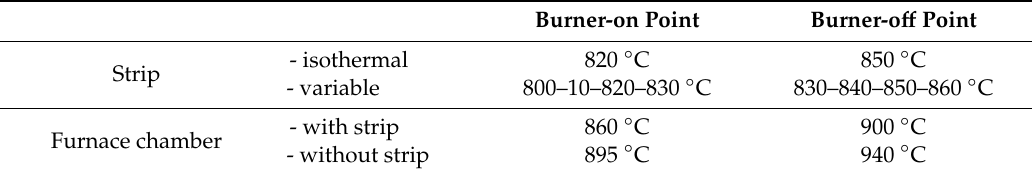
Table 3. Temperature boundary conditions for strip and furnace chamber used for all setups.